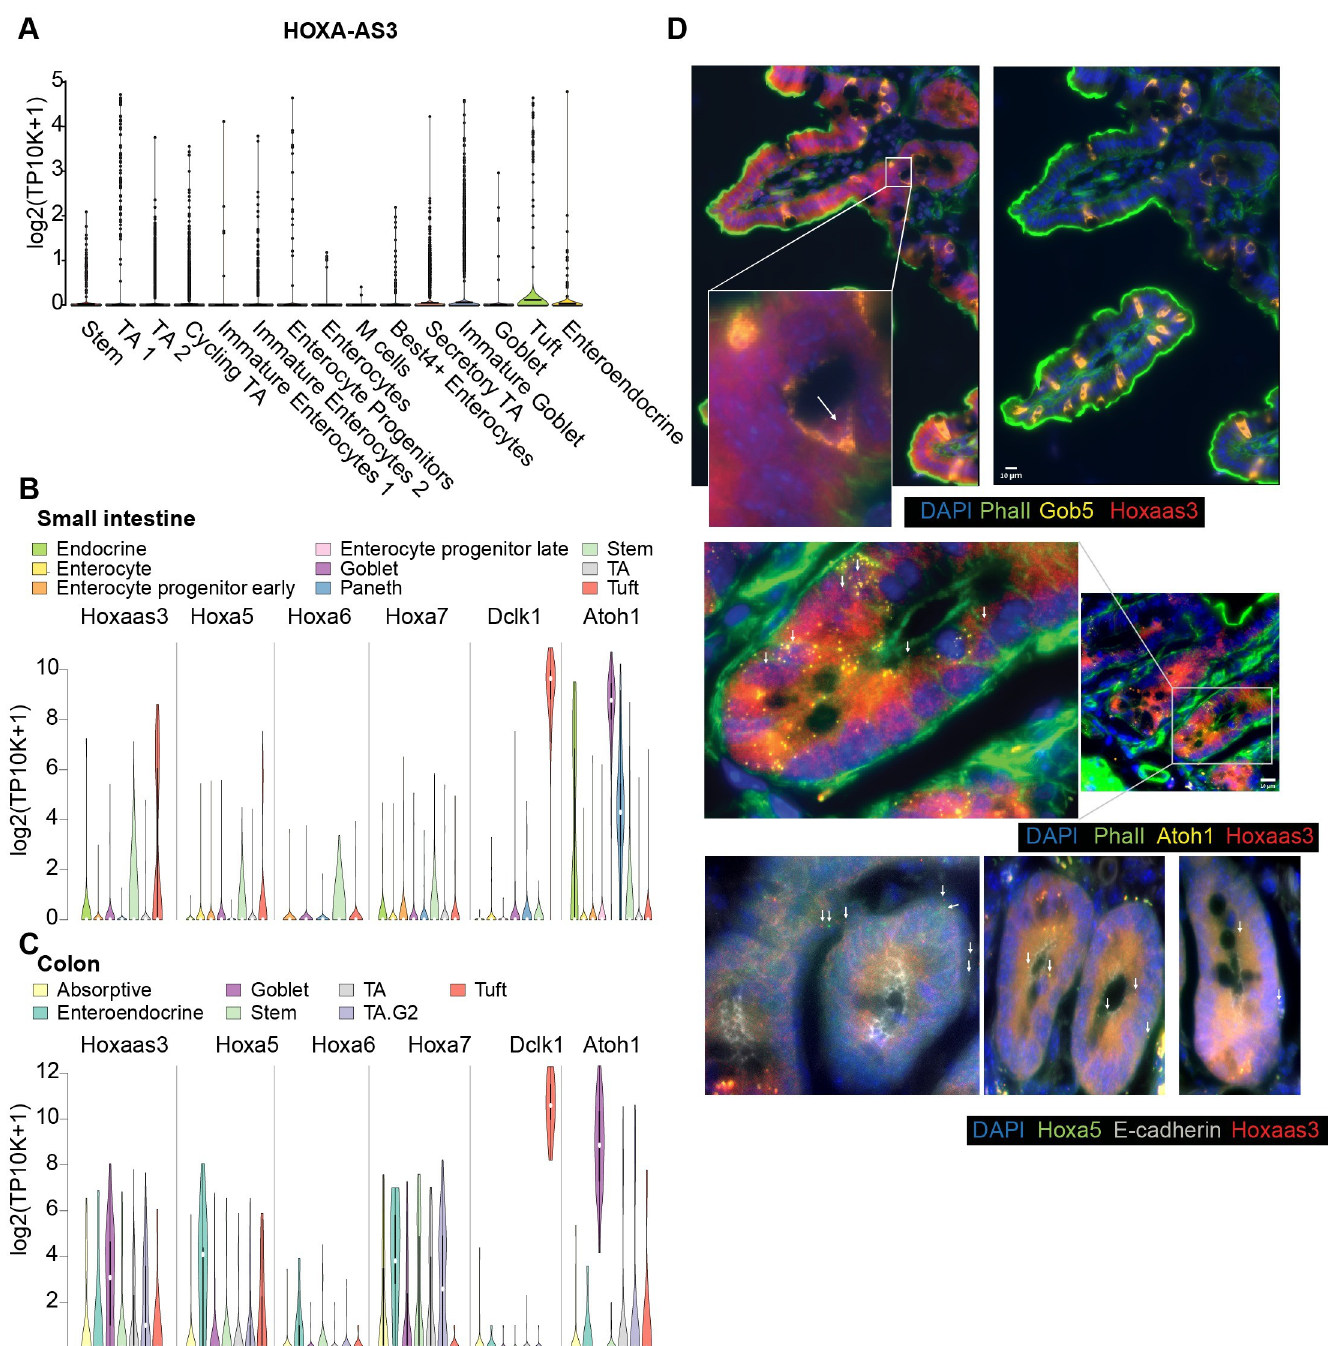
Fig 6. Expression of HOXA-AS3 in the human and mouse gut. (A) Expression of HOXA-AS3 in single cells of the human colon (data from [62]). (B-C) Expression of the indicated genes in scRNA-seq from the mouse small intestine ( B ) and colon ( C ). Data from [37]. (D) smFISH of Hoxaas3 , Hoxa5 , Gob5 and Atoh1 expression in the mouse intestine. Scale bar:10 μ m. Arrows indicate a subset of RNA molecules detected in the images. HOXB-AS3 were strongly induced and expressed only in the MHG population, alongside their adjacent HOX-6 and HOX-7 genes, whereas HOXA5 and HOXB5 were alse expressed in PFG cells ( Fig 7A ).